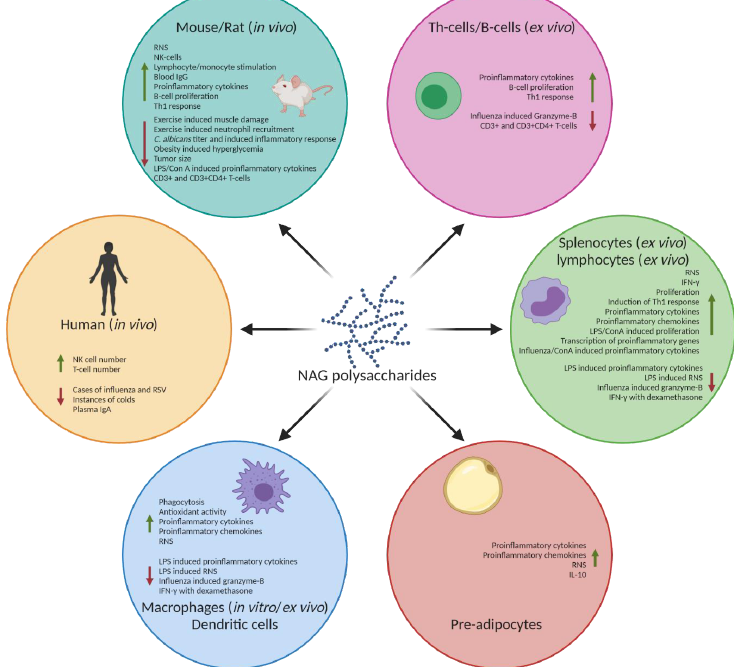
Figure 2. Immunomodulatory effects of NAG polysaccharides. NAG polysaccharides have been shown to cause an immunostimulatory response, such as increased RNS, IFN-γ, and proinflammatory